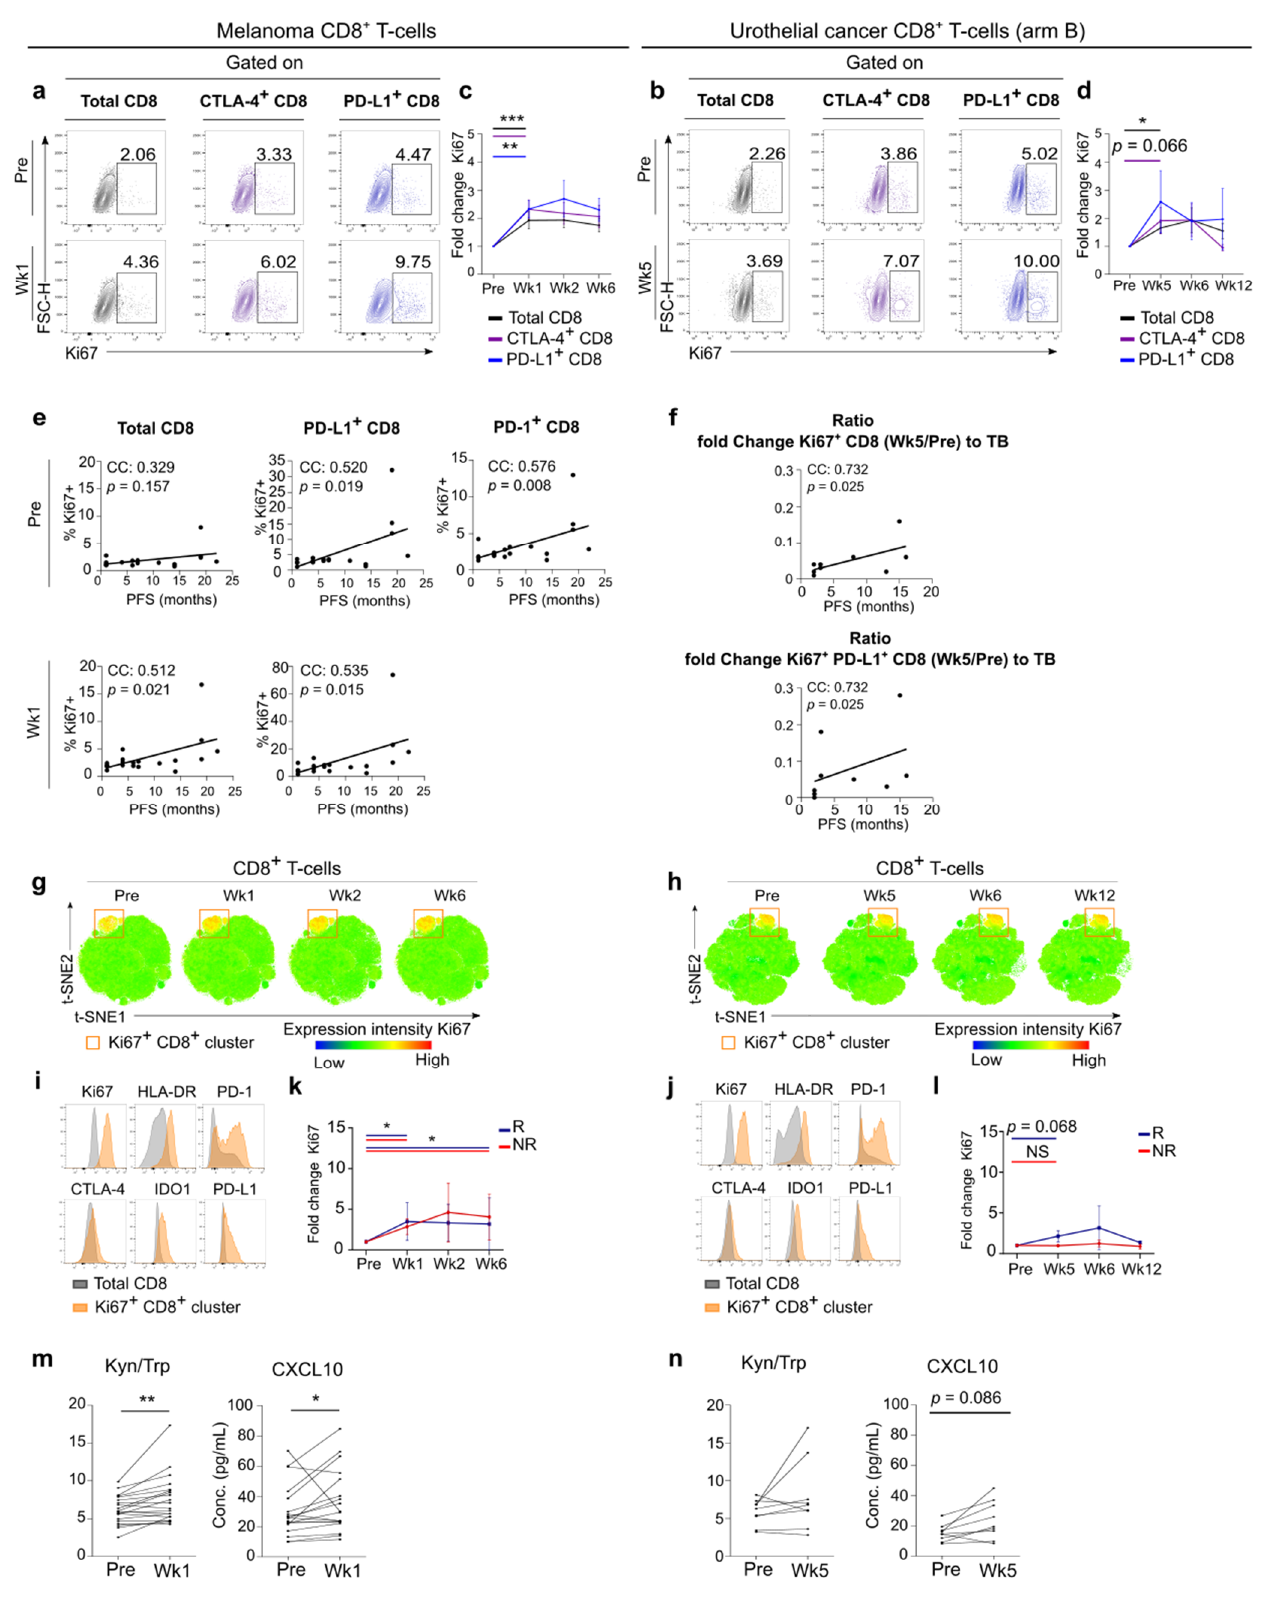
Figure 3. Early upregulation of proliferating CD8 + T-cells in response to anti-PD-1. ( a ) Contour plots representing Ki67 expression in CD8 + T-cell subsets at pre-treatment (Pre) and after 1 cycle of anti-PD-1 (Week 1) in 12 independent melanoma patients. ( b ) Contour plots representing Ki67 expression in CD8 + T-cell subsets at pre-treatment and after 2 cycles of anti-PD-1 (Week 5) in 9 independent UC patients (arm B). ( c ) Lineplot with fold induction of Ki67 expression in CD8 +